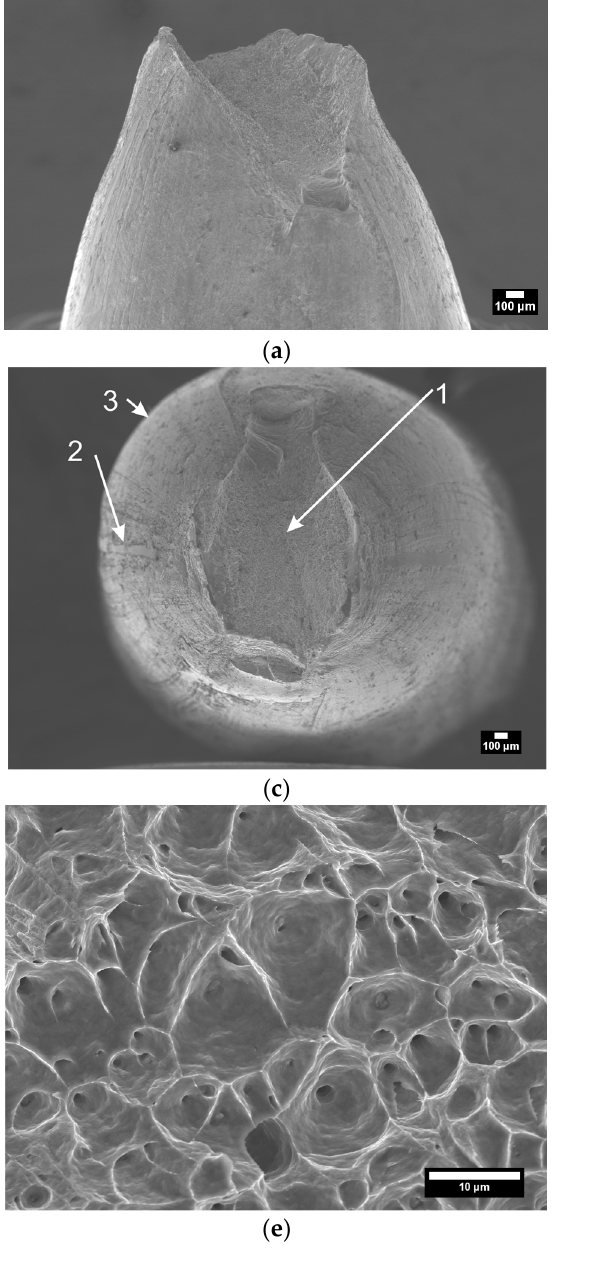
Figure 12. SEM images of the Al-wire samples ( a , c , e ) C7 and ( b , d , f ) C8 in the place of their rupture after the fatigue tests, taken laterally and frontally. Fractographic analysis of SEM images reveals different zones indicated in ( c , d ) by numbers, corresponding to, respectively, fibrous (1), radial (2), and cut (3) zones of the fracture surface. White spots on ( d ) are contamination on the surface.